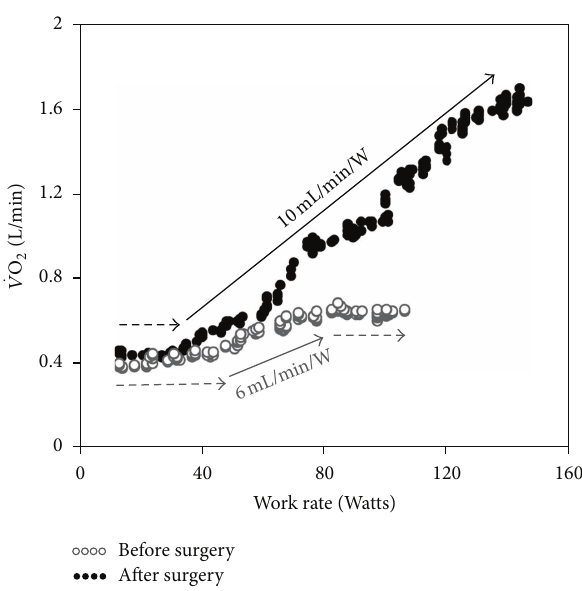
̇𝑉 )/ work rate (WR) relationship during Figure 4: Oxygen uptake ( O 2 ramp-incremental CPET before and after pulmonary endarterec- tomy in a 21-year-old male with thromboembolic occlusion of the ̇𝑉 increased leftpulmonaryartery.Notethatafterthesurgery,peak O 2 not only due to a higher peak WR but also owing to a large ̇𝑉 /Δ improvement in Δ O 2